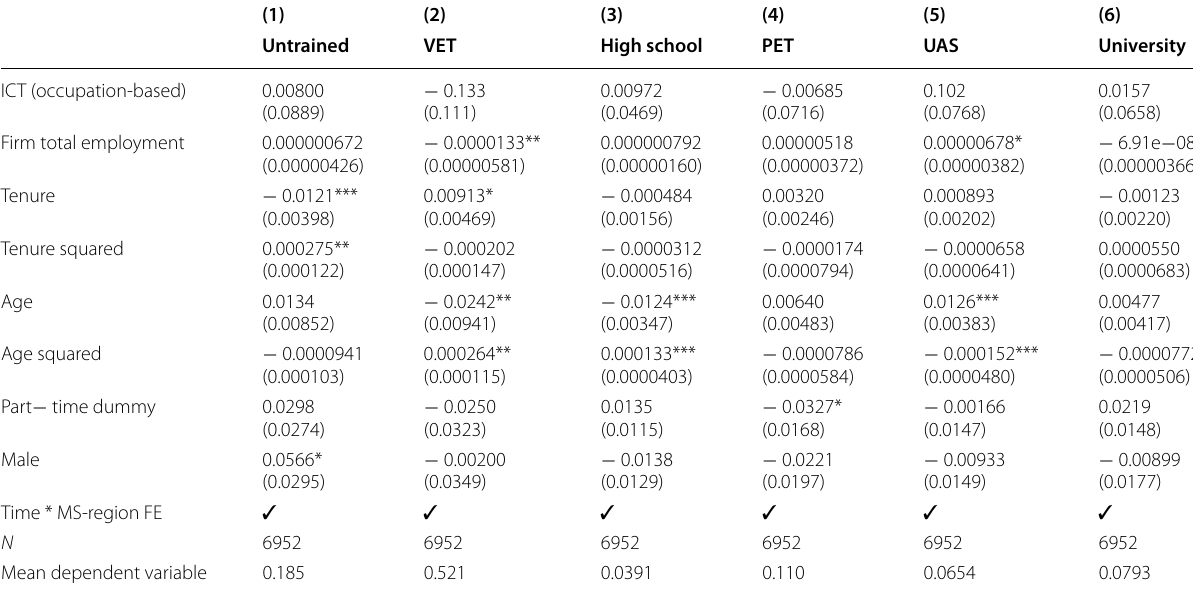
The table shows the GMM estimates of a firm pseudo-panel with cells defined according to MS-region, industry, and firm size. Standard errors in parentheses are clustered at the cell level. N reports the number of pseudo-panel cells that contain at least one firm. The main explanatory variable measures the cell percentage of ICT workers according to ICT occupations. Estimates further control for time*MS-region fixed effects and cell averages of total employment, tenure, age, part-time status, and gender. Each column shows the results for a different dependent variable measuring the percentage of workers with a particular education within the cell * P < 0.10, ** P < 0.05, *** P <